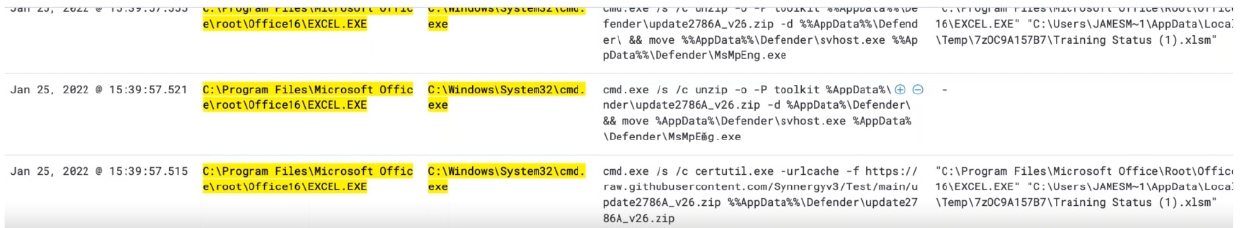
Figure 9. Payload analysis.